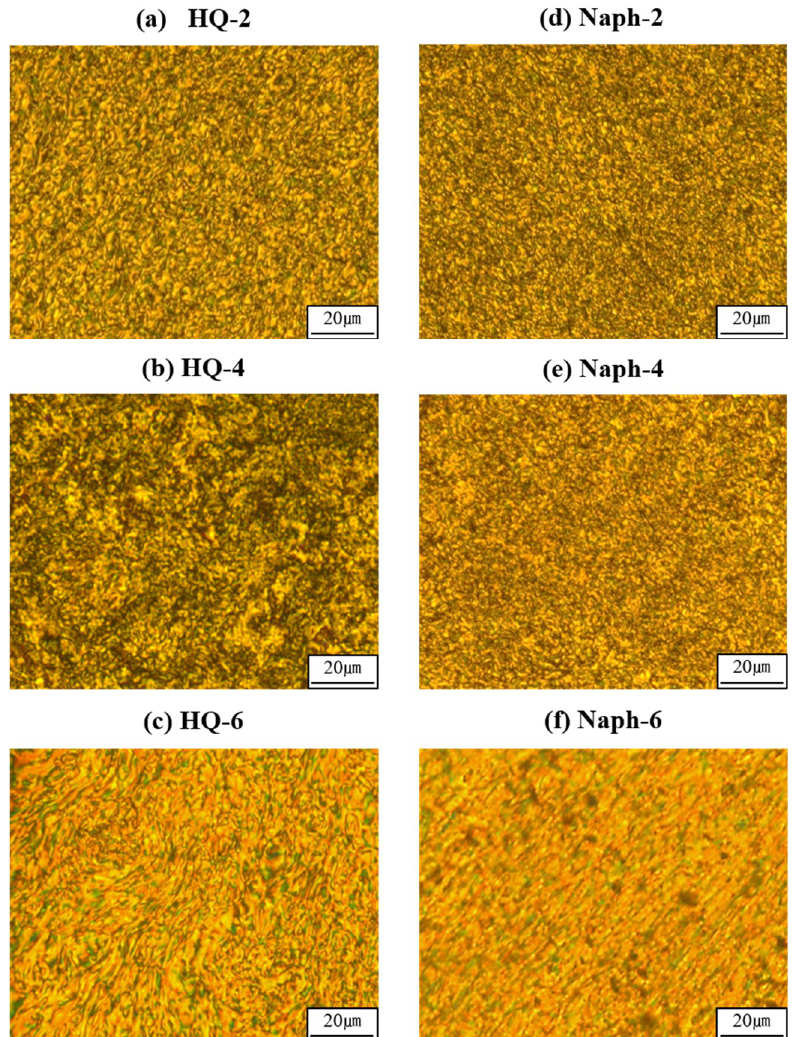
Figure 6. Polarized optical micrographs of ( a ) HQ-2 at 310 ◦ C, ( b ) HQ-4 at 255 ◦ C, ( c ) HQ-6 at 190 ◦ C, ( d ) Naph-2 at 310 ◦ C, ( e ) Naph-4 at 290 ◦ C, and ( f ) Naph-6 at 200 ◦ C (magnification 100 ×).